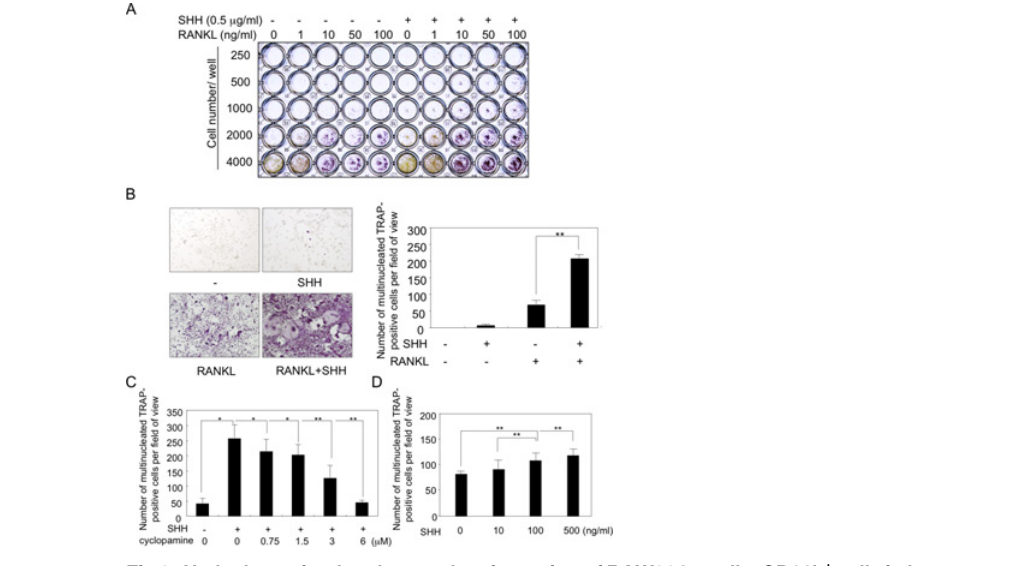
Fig 2. Hedgehog stimulated osteoclast formation of RAW264.7 cells, CD11b + cells in bone marrow, and bone marrow macrophages. ( A ) RAW264.7 cells were inoculated onto a 96-well plate at different cell densities and then treated with increasing concentrations of RANKL +/- SHH for 6 days. Osteoclast formation was evaluated by TRAP staining. ( B and C ) CD11b + cells isolated from the bone marrow of 5-week-old mice were cultured in the presence of 30 ng/ml M-CSF and 50 ng/ml RANKL with or without 500 ng/ml SHH in 96-well plate for 6 days. Cultures were also treated with or without SHH and hedgehog inhibitor cyclopamine for 6 days (C). Bone marrow macrophages were cultured with indicated amount of SHH in the presence of 30 ng/ml M-CSF and 50 ng/ml RANKL in 48-well plate for 7 days. TRAP-positive multinucleated cells (nuclear number > 3) were counted as osteoclasts. The data from a typical experiment are presented. Data are shown as the mean ± SD. Statistically significant differences ( * P < 0.05, ** P < 0.01) between the indicated groups are marked by